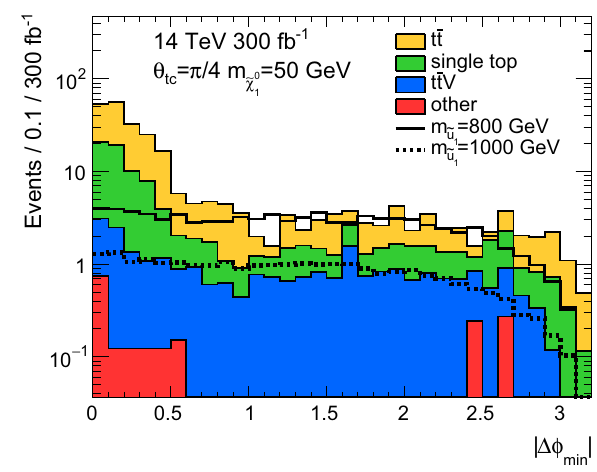
Fig. 3 Distributions in the m T2 contributions and two representative signal scenarios are shown for an (left) and | Δφ min | (right) variables blj integrated luminosity of 300 fb − 1 . For the | Δφ min | distribution, the after imposing all cuts of the Case-A analysis strategy, excepted the one m T2 corresponding to the represented variable. The different background variable is required to be larger than 400 GeV blj